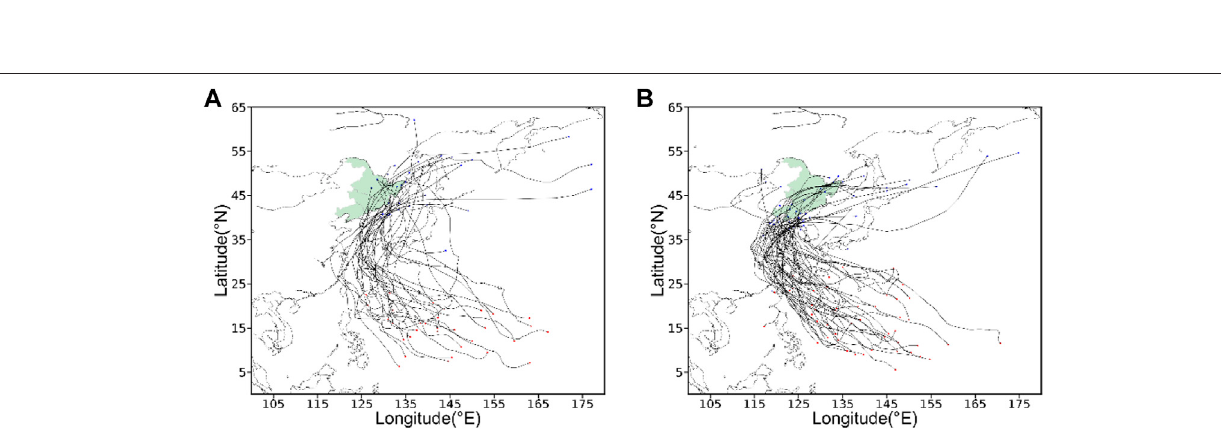
Frontiers in Earth Science |